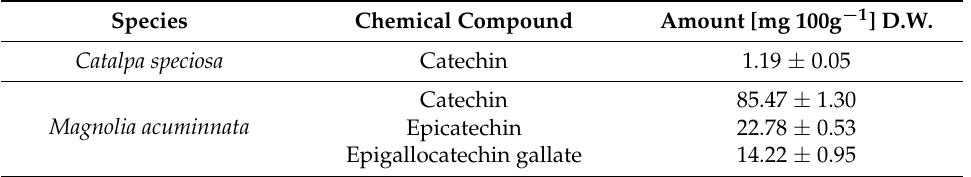
Table 2. The catechin derivatives compositions of Catalpa speciosa and Magnolia acuminnata outer bark extracts.